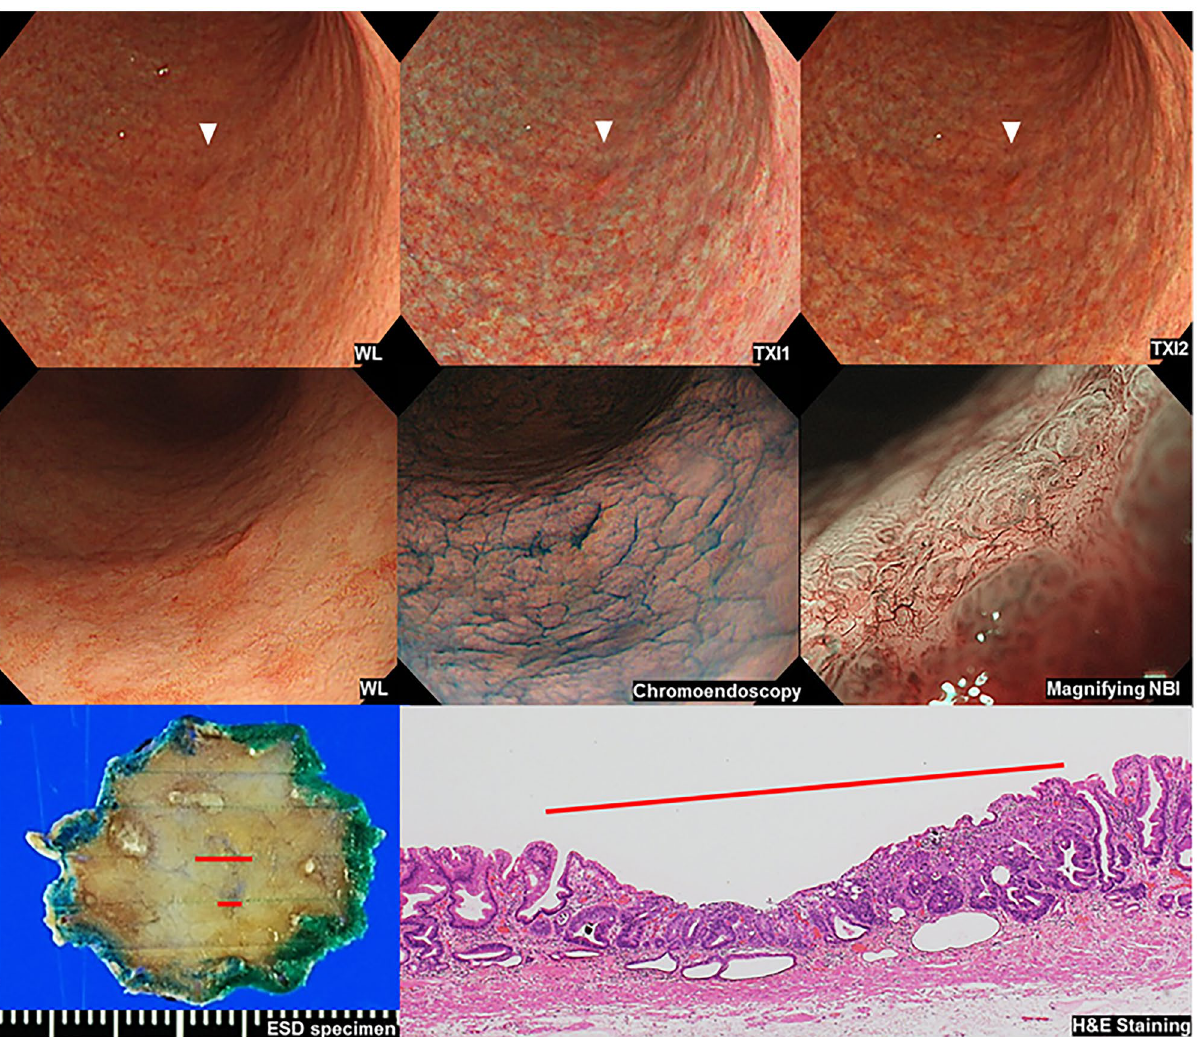
Figure 1. A representative case of EGC with improved visibility by the TXI image. In a distant view, an EGC lesion is observed as slightly reddish color change in the greater curvature of the gastric body but it seems ambiguous in WL image (upper left, white arrow head). TXI mode 1 demonstrated enhancement reddish color (upper middle, white arrow head). TXI mode 2 also demonstrated slight enhancement of reddish color (upper right, white arrow head). In a closer view, the lesion was observed as a depressed lesion (middle left). Chromoendoscopy using indigo carmine enhanced irregular shaped depression (middle center) and magnifying NBI demonstrated irregular micro vessels in the depressed area. Histological assessment of ESD specimen showed well differentiated adenocarcinoma within mucosal layer (red line, lower left and right).